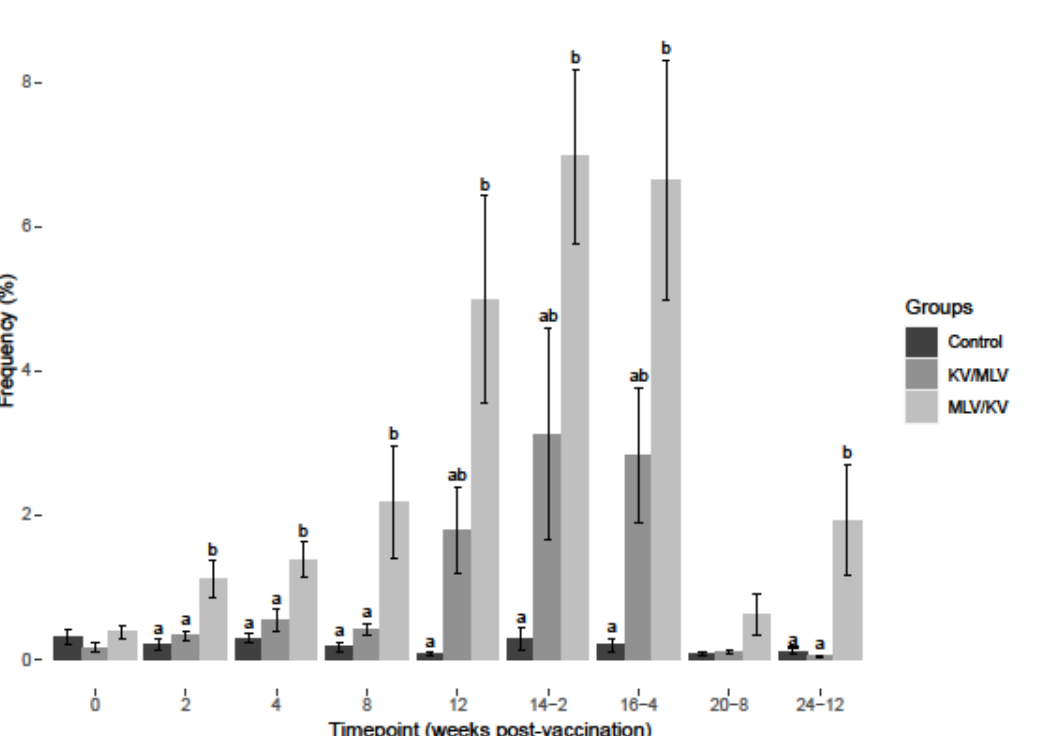
Figure 5. Frequency of IFN- γ mRNA-positive CD335 + cells after 24-hour stimulation at each respective timepoint over the course of the study with BVDV-2a (PI-28). Values at each timepoint, not connected by the same letter are significantly different ( p < 0.05).